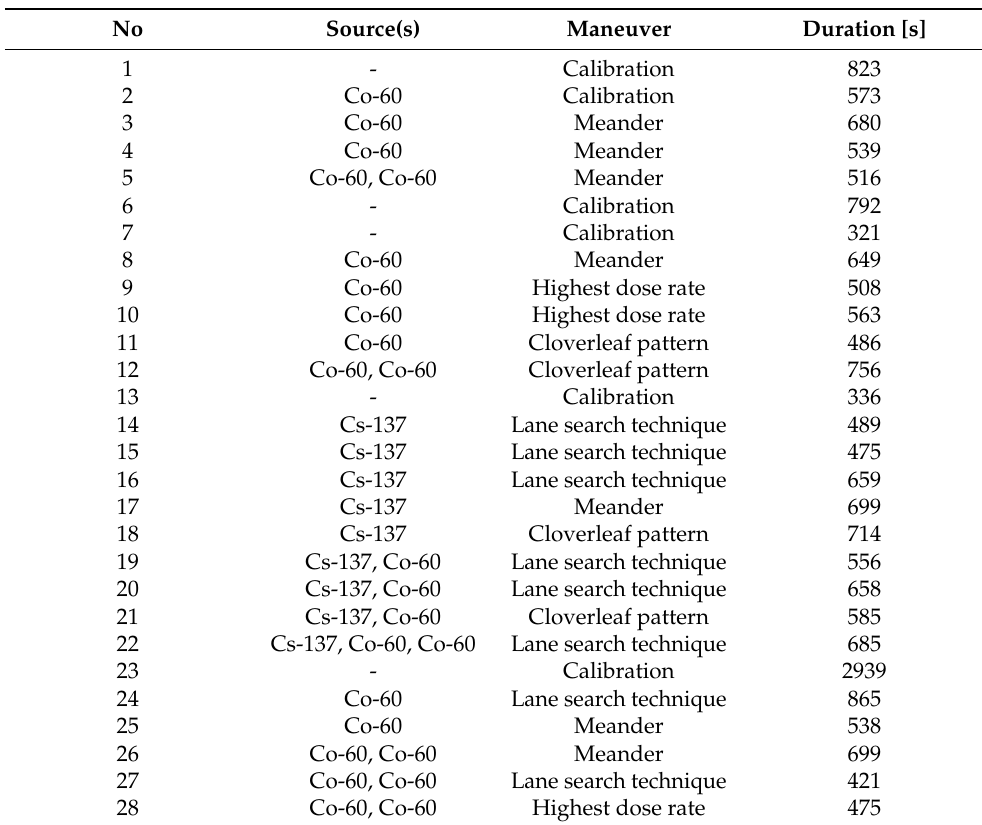
Table 1. Overview of the test